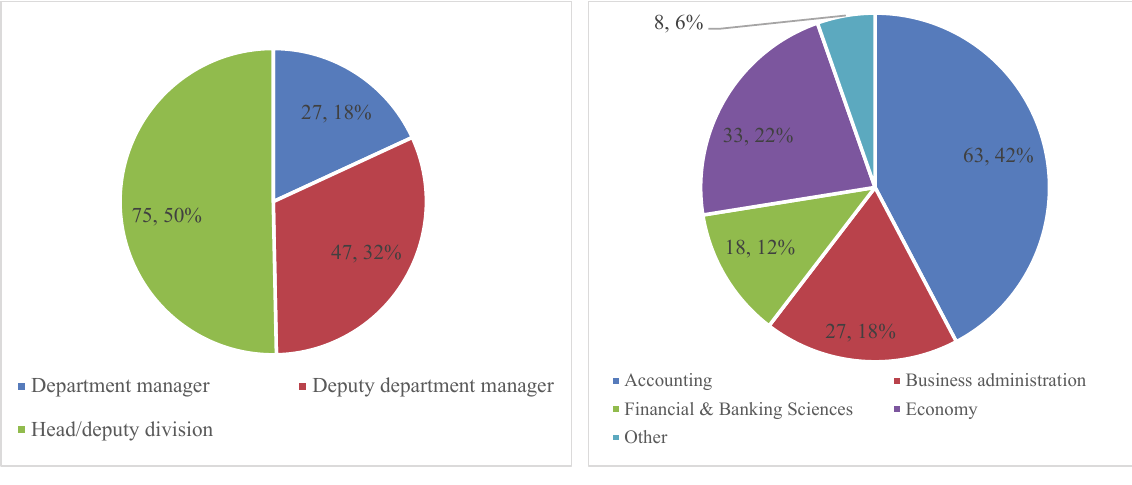
Fig. 1. Distribution of the sample according to the personal variables